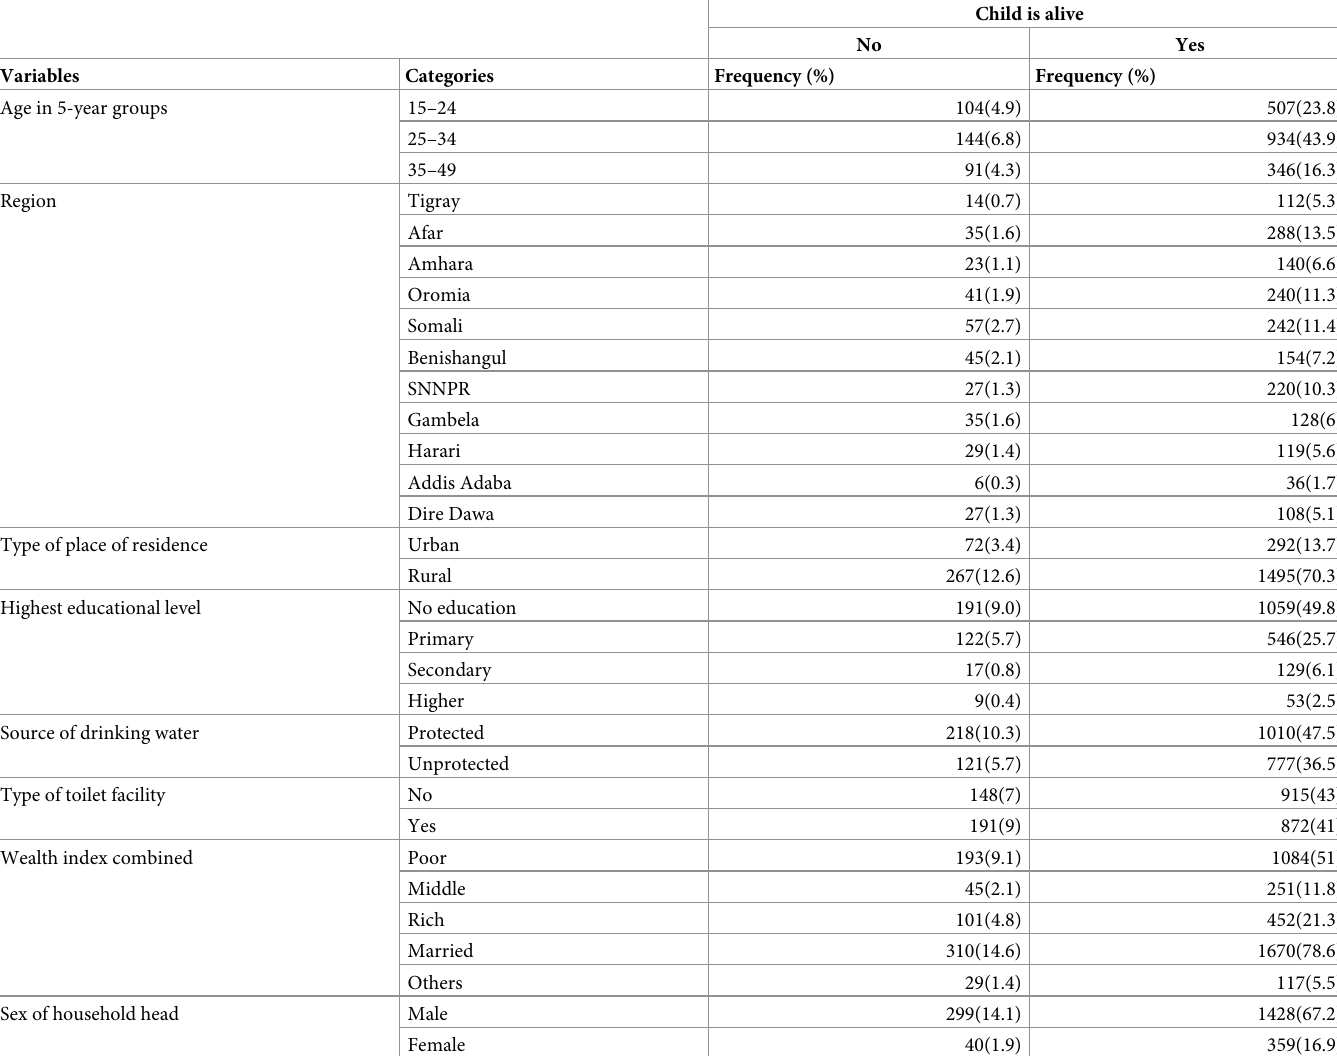
Table 2. Sociodemographic characteristics of post neonatal mortality